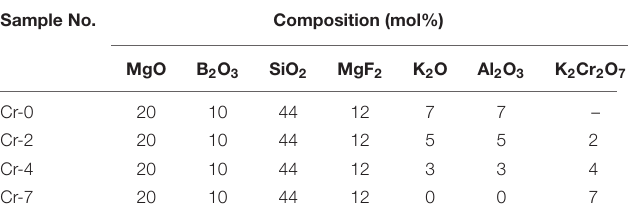
TABLE 1 | Composition of studied alkaline borosilicate glasses, K 2 O-MgO-Al 2 O 3 -B 2 O 3 -SiO 2 -F with varying K 2 Cr 2 O 7 contents. Sample